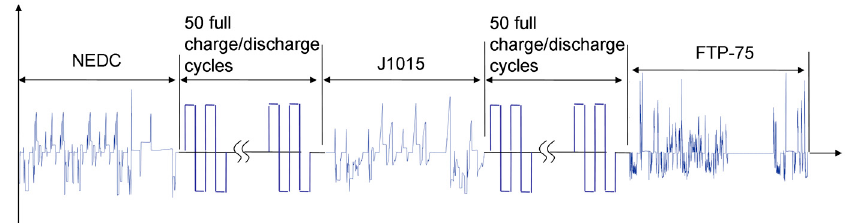
Figure 8. The overall test procedure.